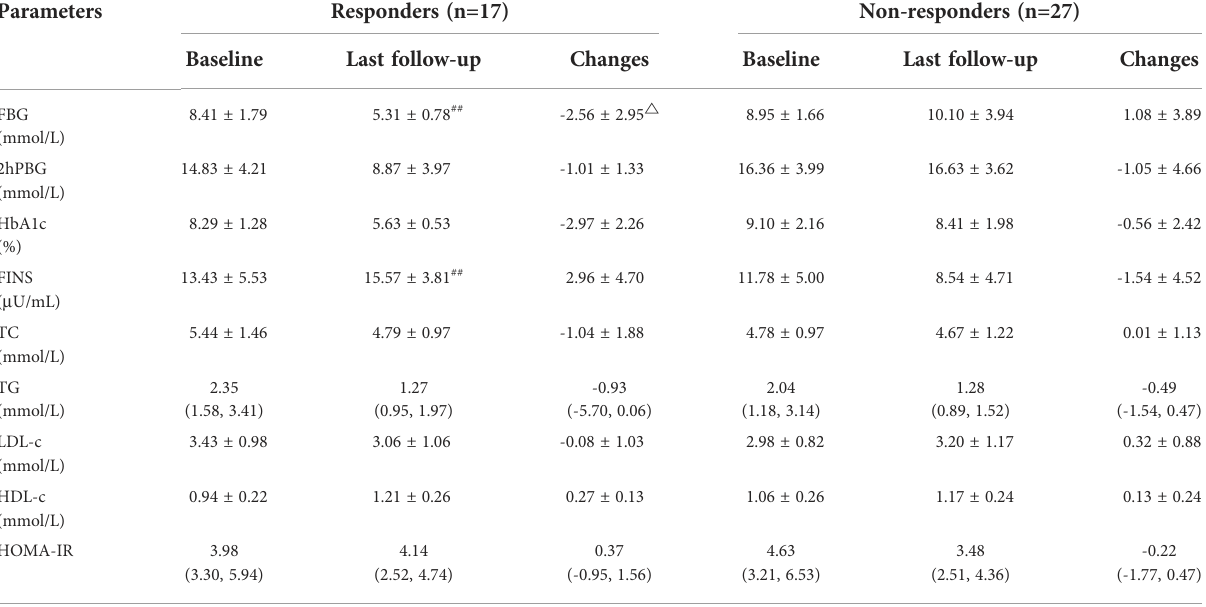
TABLE 7 Metabolic parameters at baseline and the last follow-up in responders and